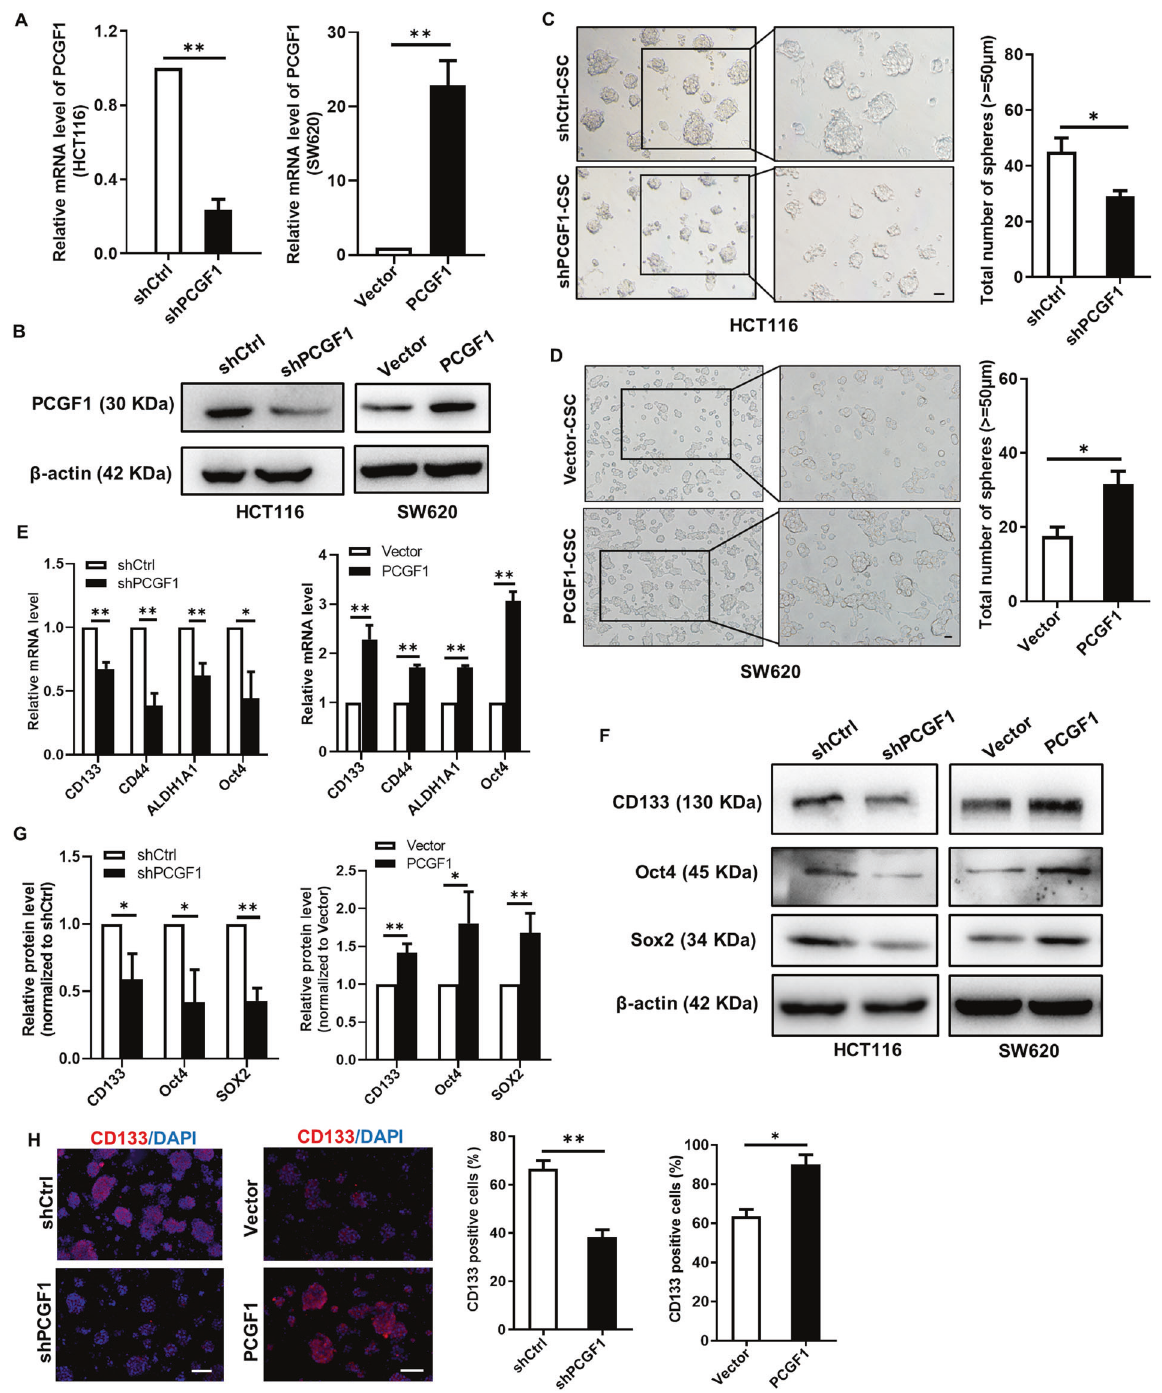
Fig. 3 PCGF1 promotes colorectal cancer stem cell enrichment. A , B RT-qPCR and western blot analyses of PCGF1 in HCT116 cells silenced with PCGF1 shRNAs and RT-qPCR and western blot analysis of PCGF1 in SW620 cells that stably overexpress PCGF1. C , D Representative micrographs and quanti fi cation of tumour spheres formed by HCT116 and SW620 cells, and the number of spheres with diameters larger than 50 μ m was counted. HCT116, Scale bar, 50 µm; SW620, Scale bar, 20 µm, right. E RT-qPCR analysis showed the mRNA expression levels of the stemness markers CD133, CD44, ALDH1A1 and Oct4 in CSC spheres with PCGF1 knockdown and overexpression. F , G Western blot analysis of stemness markers in PCGF1-overexpressing and PCGF1-silenced CSCs, and the relative intensity values (CD133/ β -actin, Oct4/ β -actin, Sox2/ β -actin) were measured with ImageJ software. H Immuno fl uorescent staining of CD133 expression in CSCs. Bar graphs show the statistical data for CD133-positive cells. Scale bar, 100 µm. shCtrl, shControl. *p < 0.05. **p < 0.01, t -test. Data are shown as the mean ± SEM of at least three replicates. β -actin was used as a loading